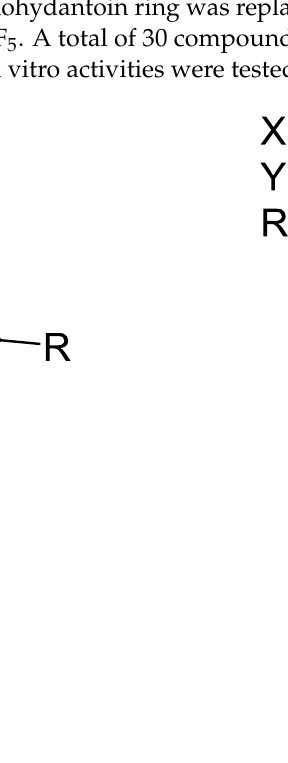
Figure 2. Design of nonsteroidal androgen receptor antagonists.